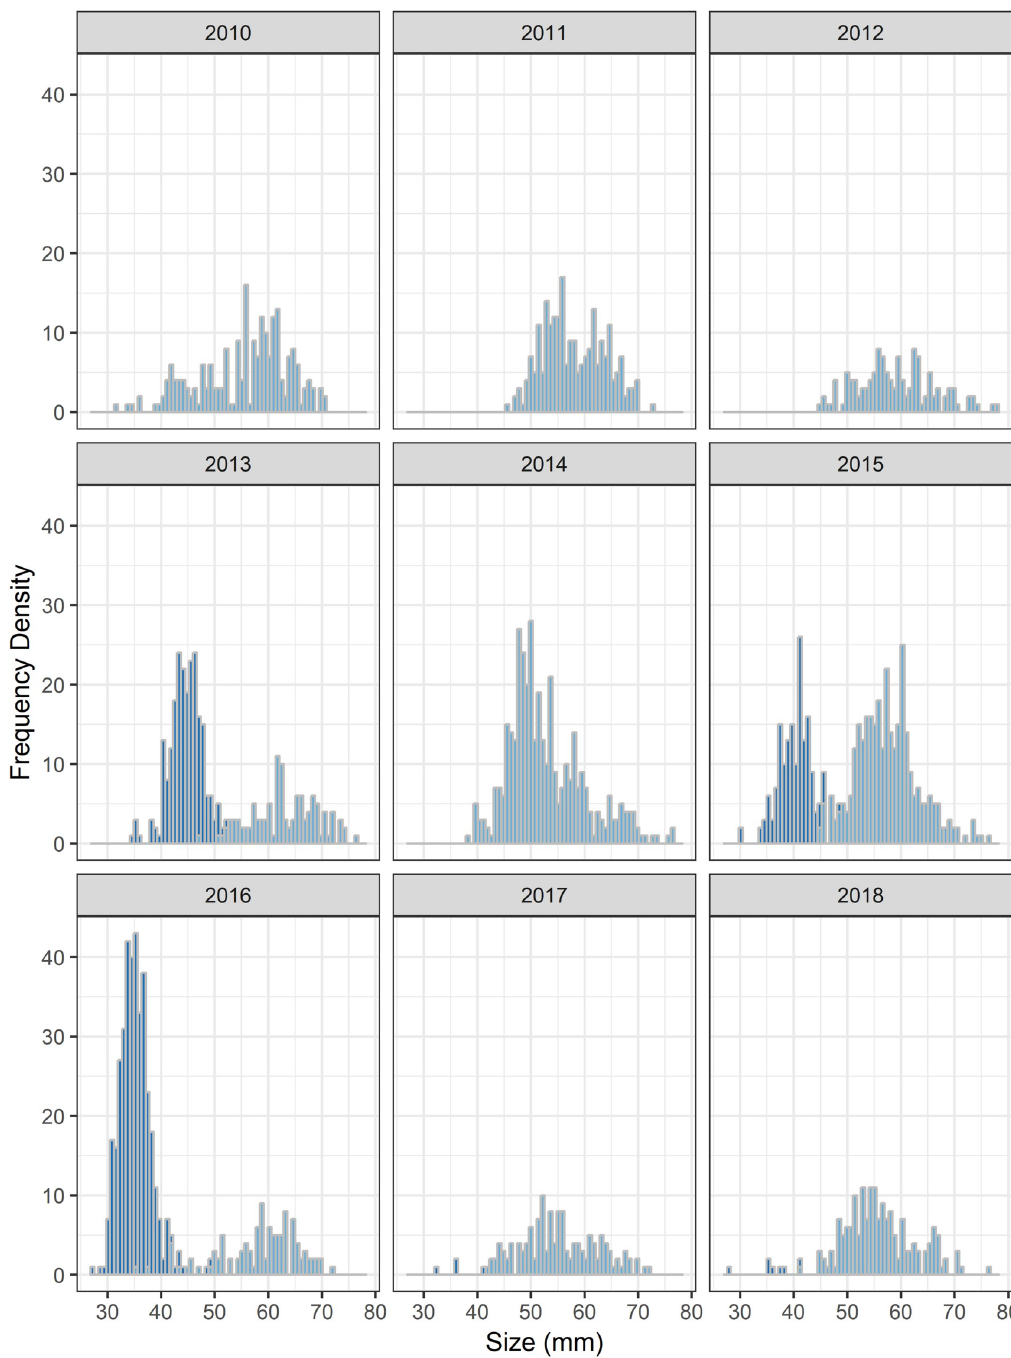
Fig 3. Adult size distribution. Size distribution of reticulated flatwoods salamanders captured as terrestrial forms at two drift- fenced wetlands on Eglin Air Force Base, Florida, across years. Histogram of snout-vent length (SVL) for post-metamorphic individuals by breeding season. Data are partitioned into adults (light blue bars), and yearlings (dark blue bars).